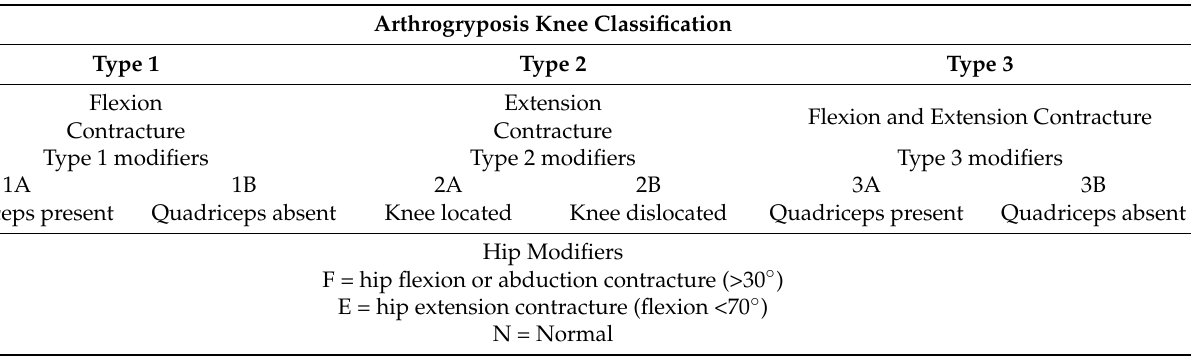
Table 1. Knee classification according to type of contracture. Each knee type has an A or B modifier as well as a hip modifier. Arthrogryposis Knee